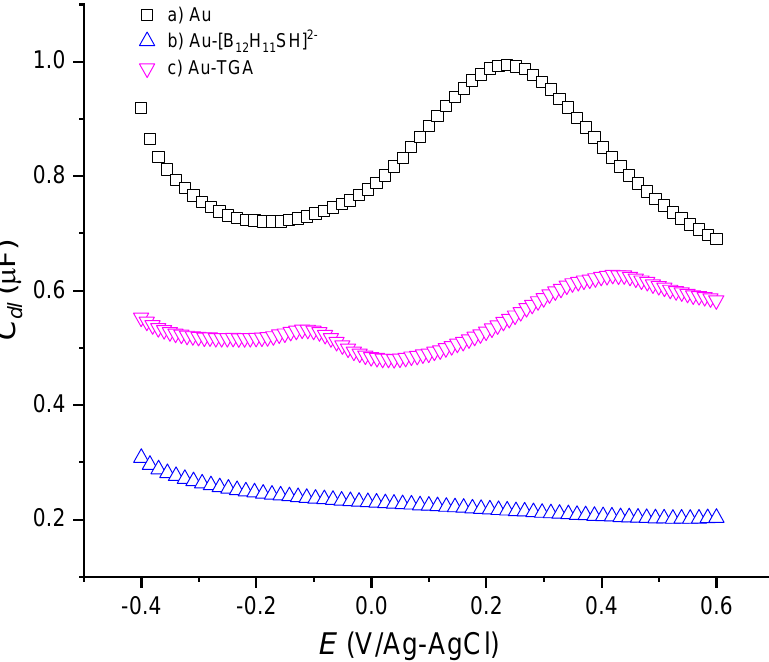
Figure 6. Differential capacitance curves for (a) bare Au electrode and (b) Au electrode modified with [B 12 H 11 SH] 2 − and (c) Au electrode modified with TGA.